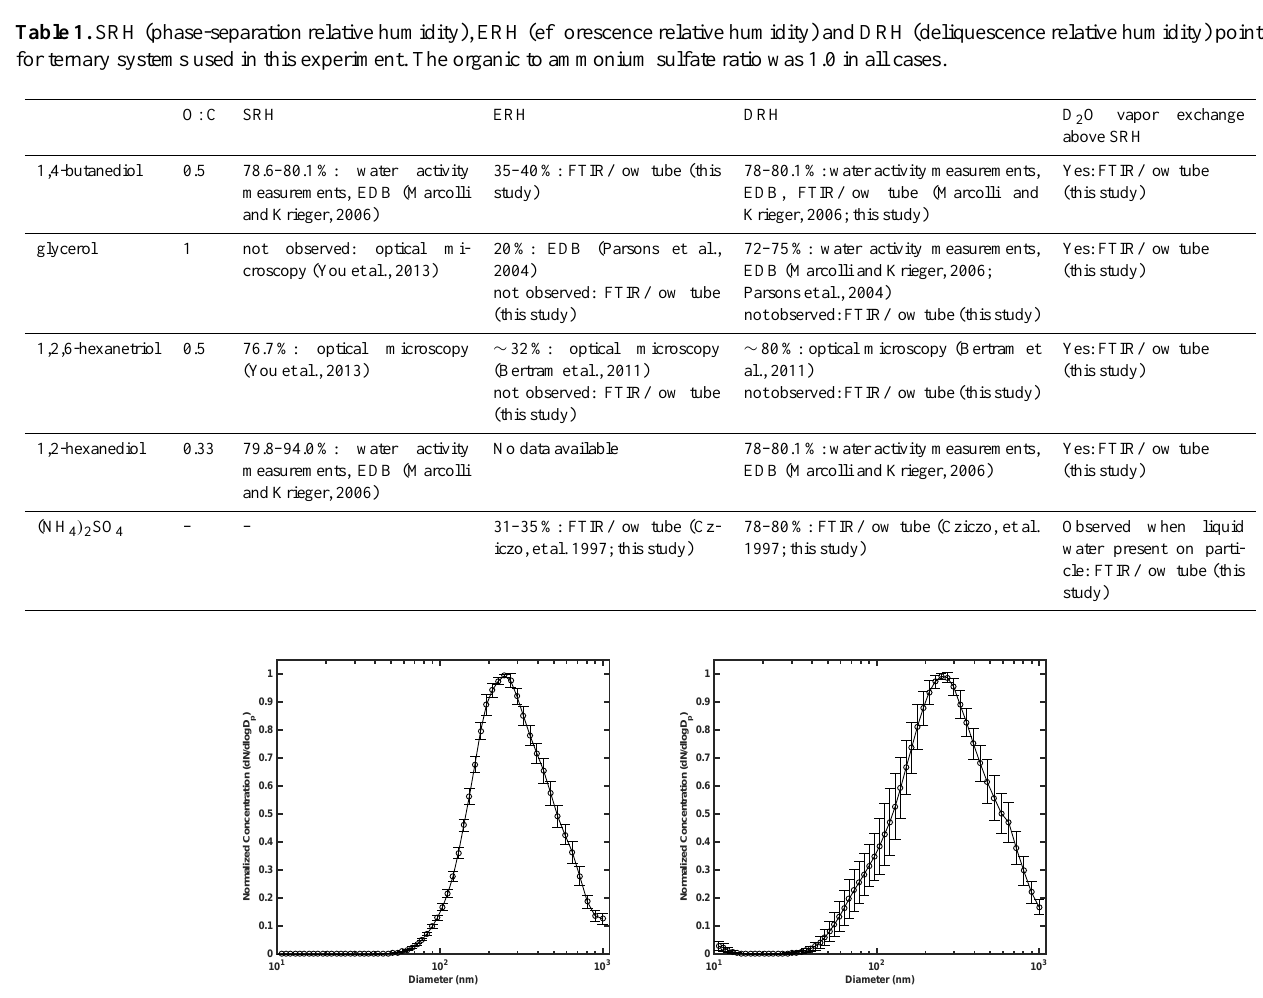
Figure 1. Size distributions measured with an SMPS for particles dispersed with the atomizer used throughout this work, dried with a silica gel dryer and mixed in a 9L mixing volume. Both distributions are the result of six SMPS scans averaged. The error bars represent the standard deviation of the scans. Left side: atomized solution of 10% ammonium sulfate. Right side: atomized solution of 5% ammonium sulfate and 5%